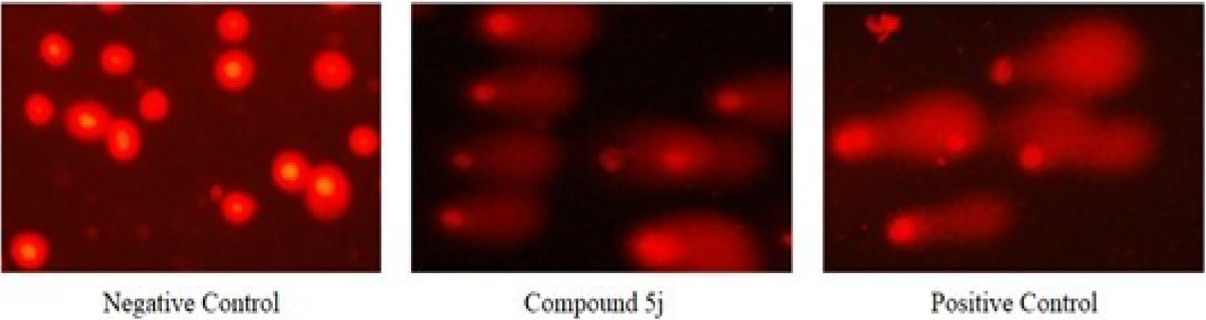
Figure 6. Representative images of comets obtained from untreated, compound 5j treated and H 2 O 2 treated HeLa cells by alkaline comet assay to assess DNA damage.